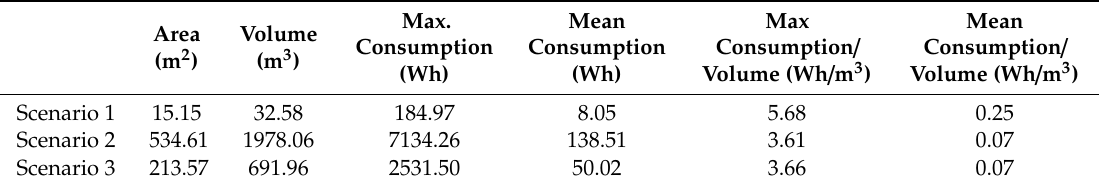
Table 2. Data from the heating system simulation with the estimated